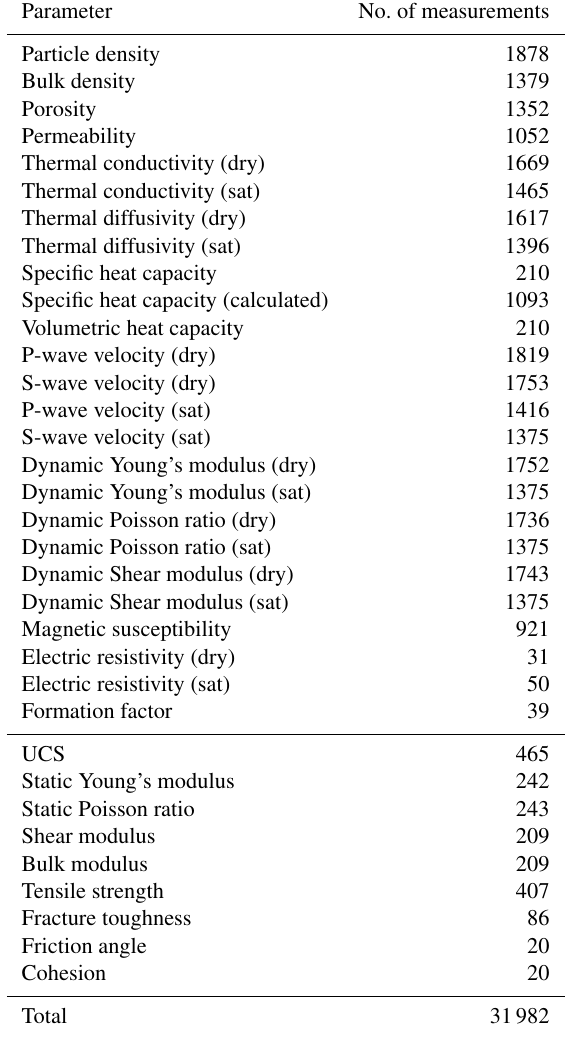
Table 2. Number of measurements for each